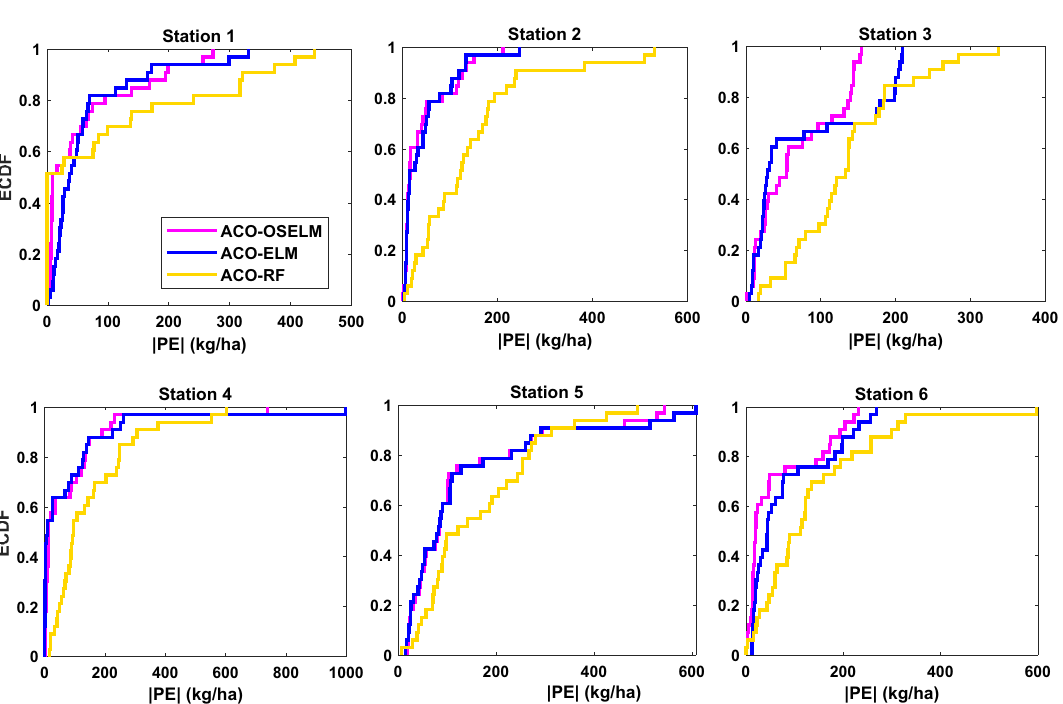
Figure 10. Empirical cumulative distribution function (ECDF) of the prediction error, |PE| (kg ha −1 ) for the testing stations using ACO-OSELM versus ACO-ELM and ACO-RF